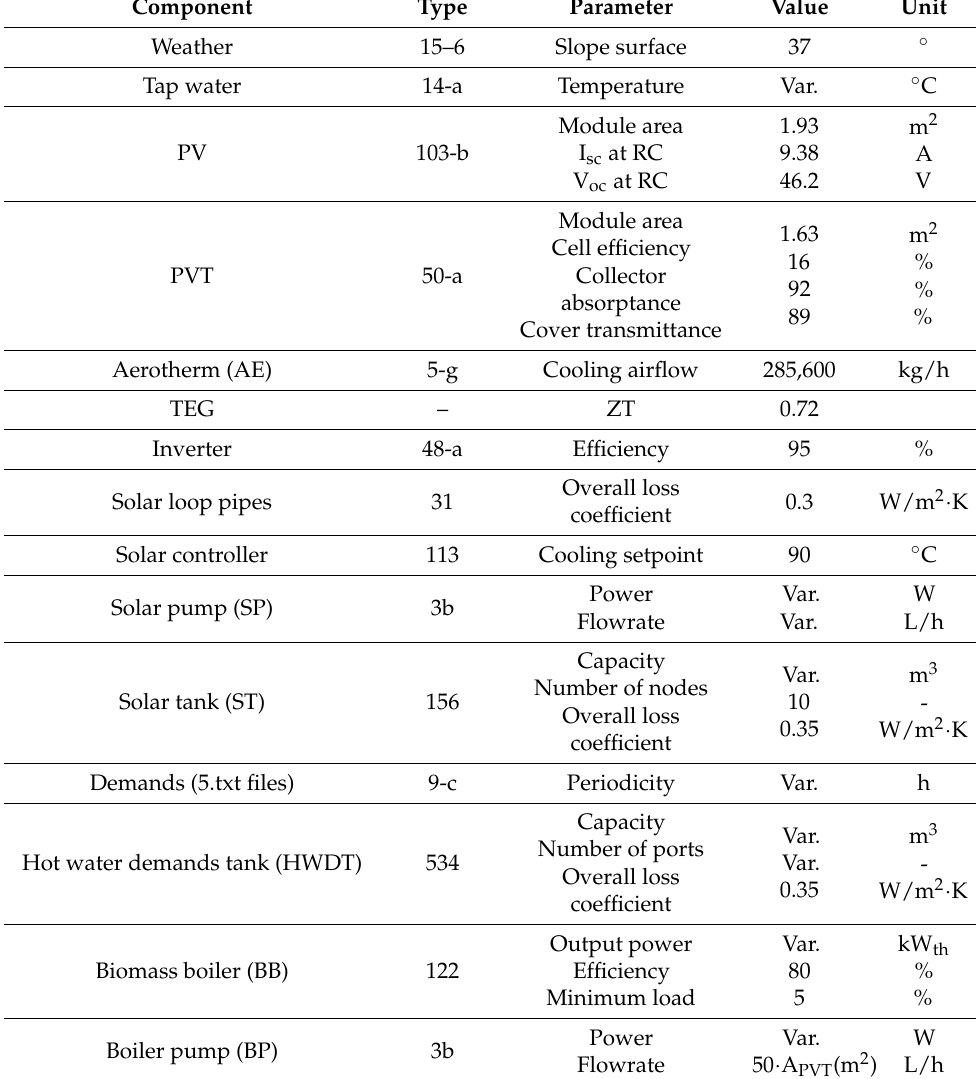
Table 5. Summary of main components of the TRNSYS